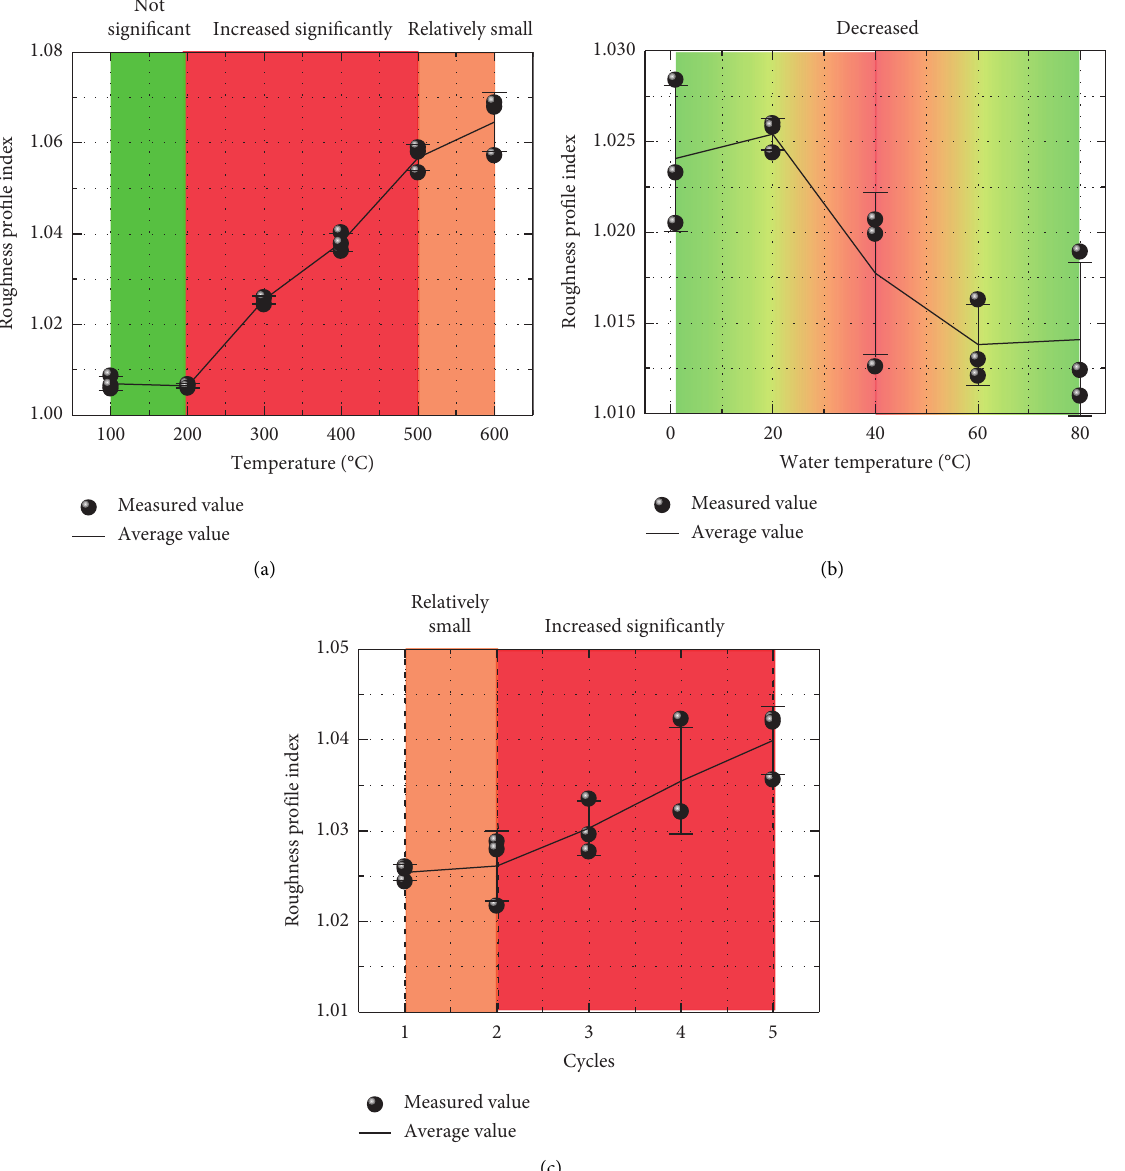
Figure 10: Roughness profile index of the specimen split surface under different conditions of water cooling at high temperatures. (a) HDR temperature. (b) Water temperature. (c) The number of heating-cooling